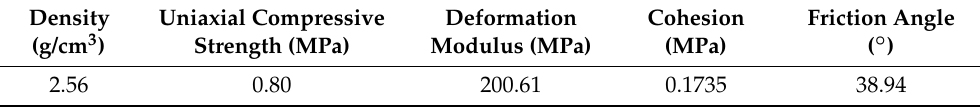
Table 4. Mechanical properties of the model rock